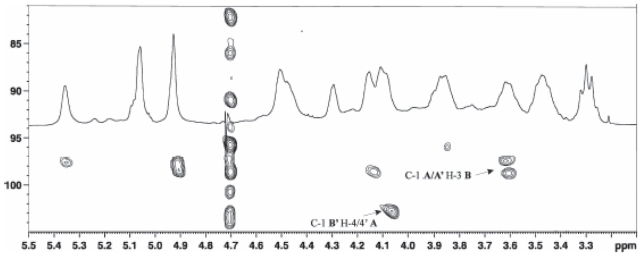
Relevant HMBC correlation of the anomeric region of the O-chain from Pseudomonas tolaasii.